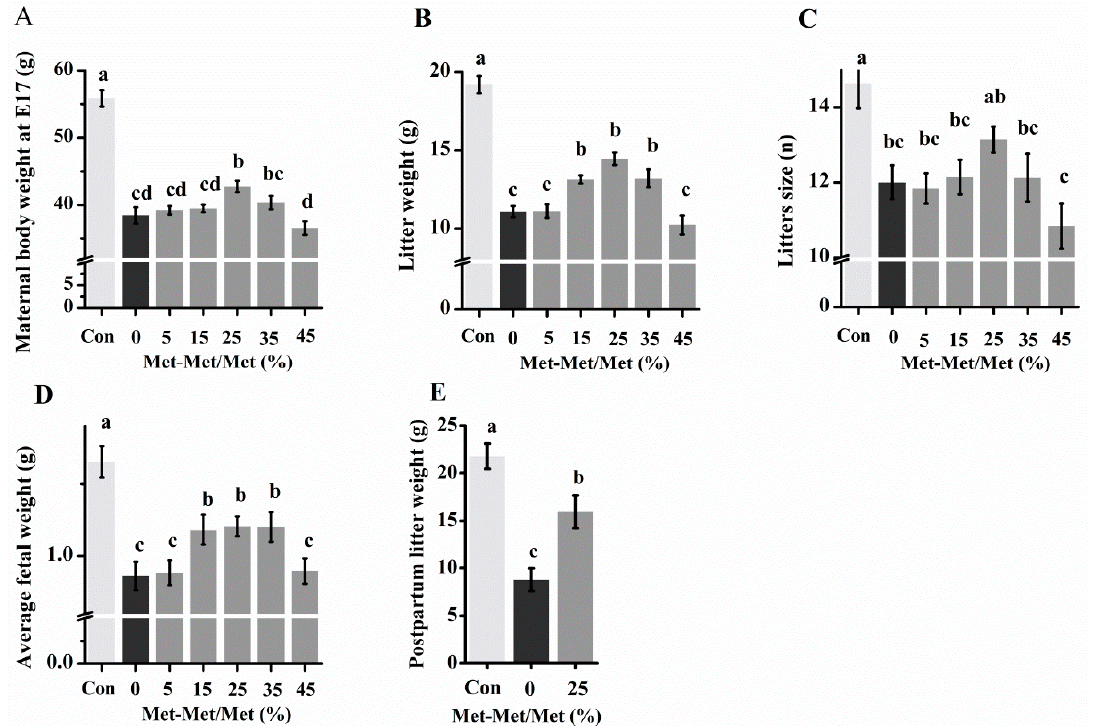
Figure 3. Maternal body weight ( A ), litter weight ( B ), litter size ( C ), and average fetal weight ( D ) at day 17 and postpartum litter weight ( E ) with different levels of methionine (Met) supplementation as methionyl-methionine (Met-Met). The control group (Con) was fed a diet with Met, and the 35% Met group was fed a Met-deficient diet supplemented with 35% of the Met in the control diet by intraperitoneallyinjection from conception. In the 5, 15, 25, 35, and 45% Met-Met groups, 5, 15, 25, 35, or 45% Met in the 35% Met group was replaced with Met-Met. Data are expressed as the mean ± SEM, n = 6–8. The different letters indicate significant differences, p < 0.05.